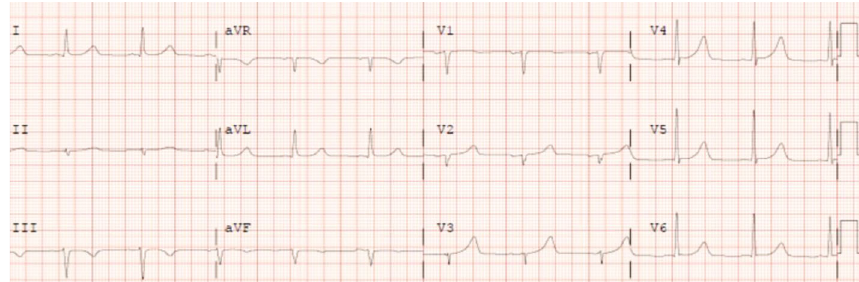
Figure 3: Patient ’ s EKG after completion of amiodarone bolus showing resolution of supraventricular